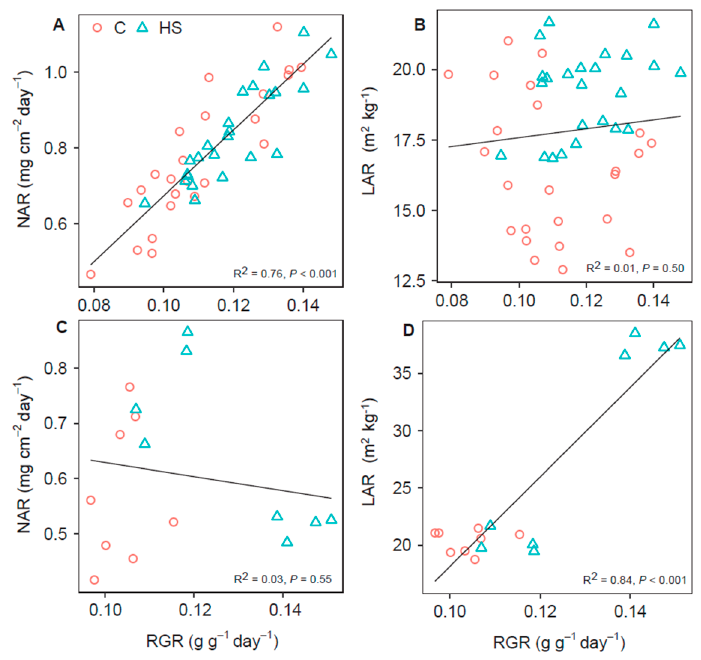
Figure 6. Linear regression plotted for net assimilation rate (NAR) and leaf area ratio (LAR) against relative growth rate (RGR) of ( A , B ) fruit-based vegetables (pepper, tomato, watermelon) and ( C , D ) leaf-based vegetable (lettuce).